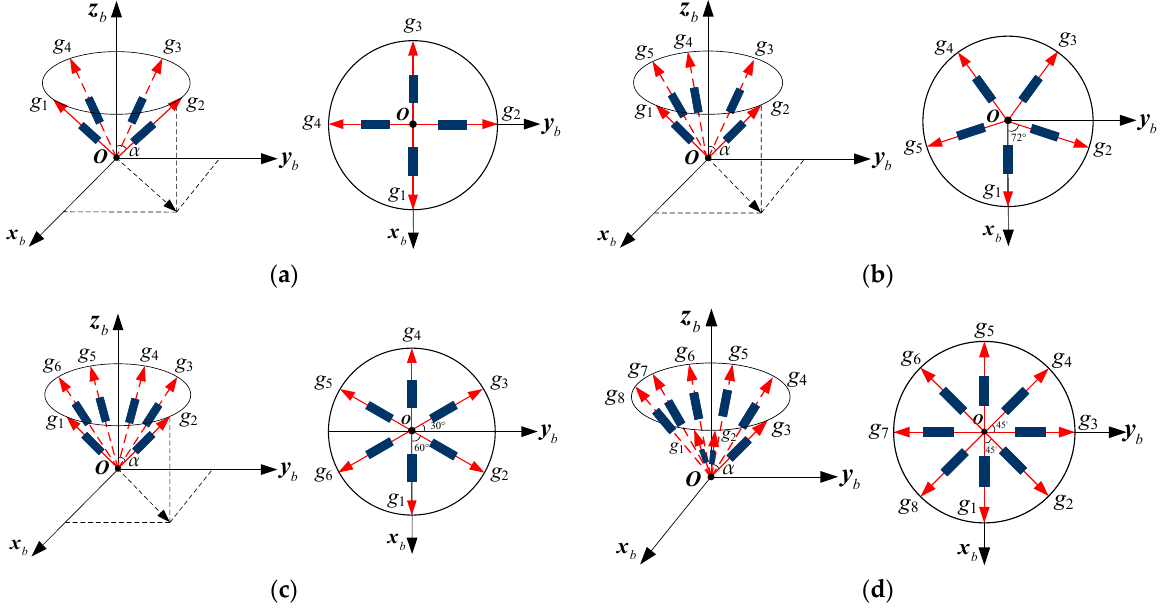
Figure 6. Non-orthogonal gyro array for a MIMU without a one-axis conical sensor: ( a ) 4-gyro cone; ( b ) 5-gyro cone; ( c ) 6-gyro cone; ( d ) 8-gyro cone. Scheme 2: Multiple gyroscopes are arranged as a cone and evenly distributed around the MIMU’s body frame’s Z b axis—in particular, one gyro’s sensitive axis coincides with the axis + Z b , and the other gyroscopes are evenly distributed around the + Z b axis, as shown in Figure 7. Specifically, the angle between the gyro’s sensitive axis and + Z b axis is α , and the projection of g1’s sensitive axis on the horizontal plane coincides with axis + X b . For N = 4 in Figure 7a, the angles between the + X b axis and projections of g1, g2 and g3’s sensitive axes on the horizontal plane are 0 ◦ , 120 ◦ , 240 ◦ , respectively. For N = 5, 6 and 8, the angles between the projections of contiguous gyros’ sensitive axis on the horizontal plane are 90 ◦ , 72 ◦ and 360/7 ◦ , respectively, which are shown in Figure